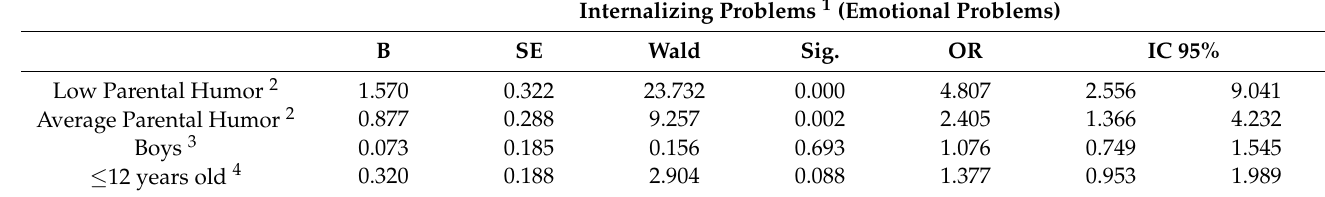
Table 2. Binomial Logistic Regression and Odds Ratio based on dependent variable Internalizing Problems and Parental Humor.